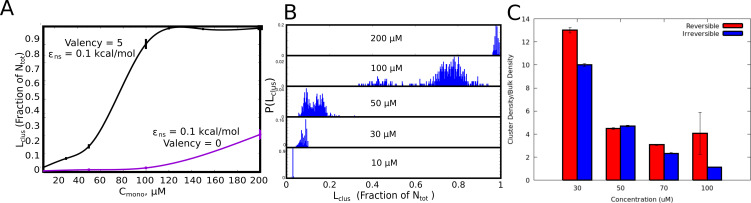
Cluster Sizes in Langevin Dynamics simulations.(A) The single largest cluster as a function of free monomer concentration (in μM). The largest cluster size is shown as a fraction of the total number of monomers in the simulation box. The smooth curves are plotted as a guide to the eye, using the cspline curve fitting. The vertical bars represent the standard error. (B) Cluster size distributions for increasing free monomer concentrations. The linker stiffness for the self-assembling polymer chains in this plot is two kcal/mol while the strength of inter-linker interaction is 0.1 kcal/mol (per pair of interacting beads). The simulations were performed for an instantaneous bond formation assumption (Pf⁢o⁢r⁢m=1). (C) Comparison of mean intra-cluster density (ϕc⁢l⁢u⁢s/ϕ) as a function of concentration for reversible and irreversible crosslinks.